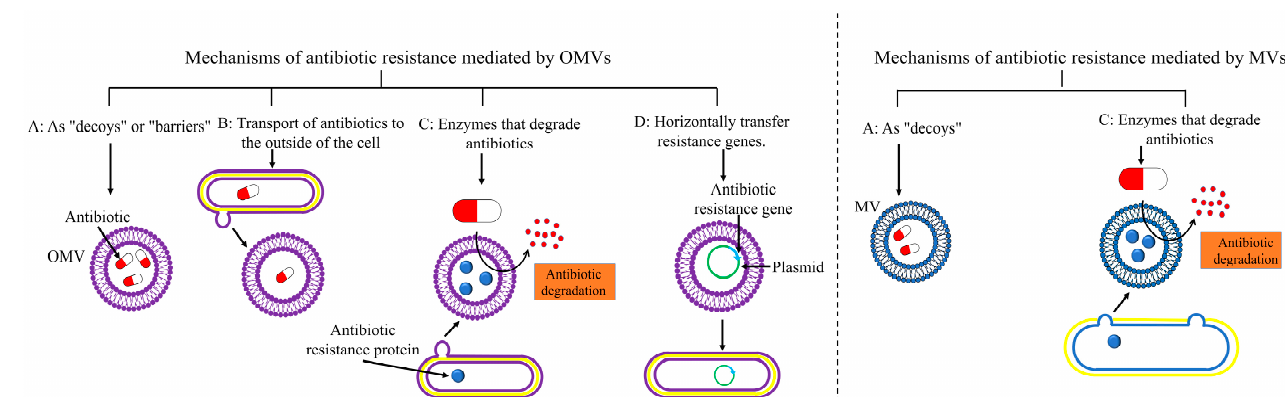
Figure 5. Mechanisms of antibiotic resistance mediated by BMVs. The left picture shows OMVs of Gram-negative bacteria, and the right picture shows MVs of Gram-positive bacteria.